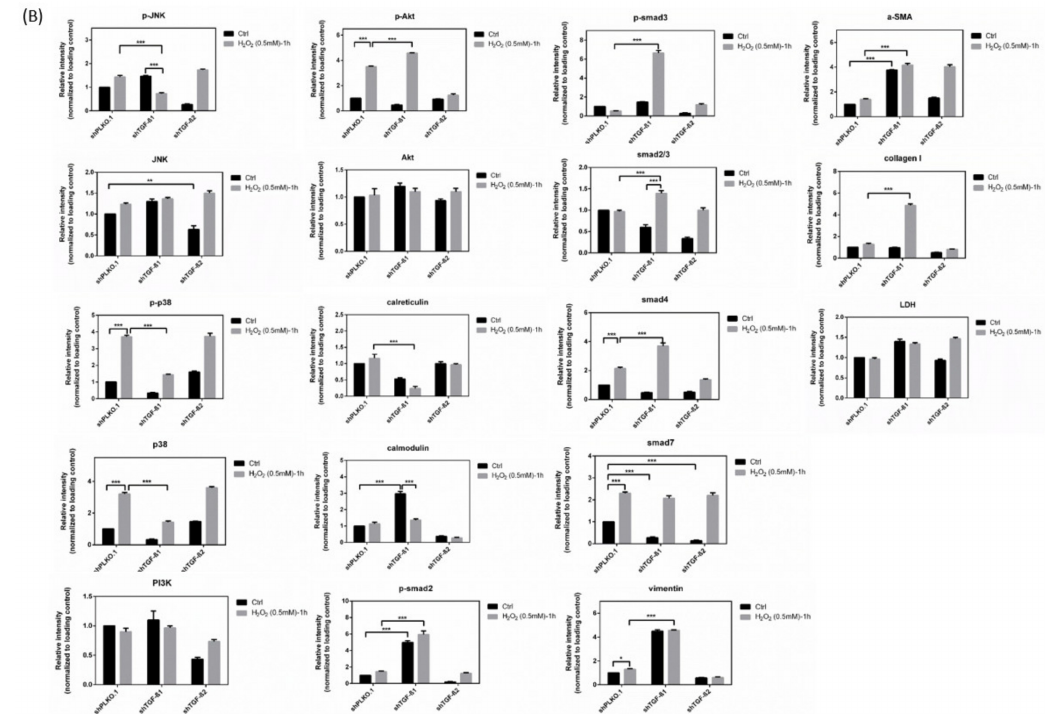
Figure 8. Immunoblot analysis and identification of shTGF- β 1/2 knockdown HTMCs in oxidative stress pathways. ( A ) shPLKO.1 (control), shTGF- β 1, and shTGF- β 2 knockdown HTMCs were collected after treatment with H 2 O 2 (0.5 mM) induced for 1 h, and cellular extracts were immunoblotted with p-JNK, JNK, p-p38, p38, PI3K, p-AKT, AKT, calreticulin, calmodulin, p-SMAD2, p-SMAD3, SMAD2/3, SMAD4, SMAD7, vimentin, α -SMA, and collagen I, as shown via protein bands. An oxidative stress-dependent increase in ECM proteins, vimentin, and stress response (especially the p-p38 pathway) is evident. Numbers under each protein band reflect the densitometry value. ( B ) The protein expression intensities were quantified in relation to the loading control. Statistic chart were represented as means ± SEM. *, p < 0.05; **, p < 0.01; ***, p < 0.001 ( n =